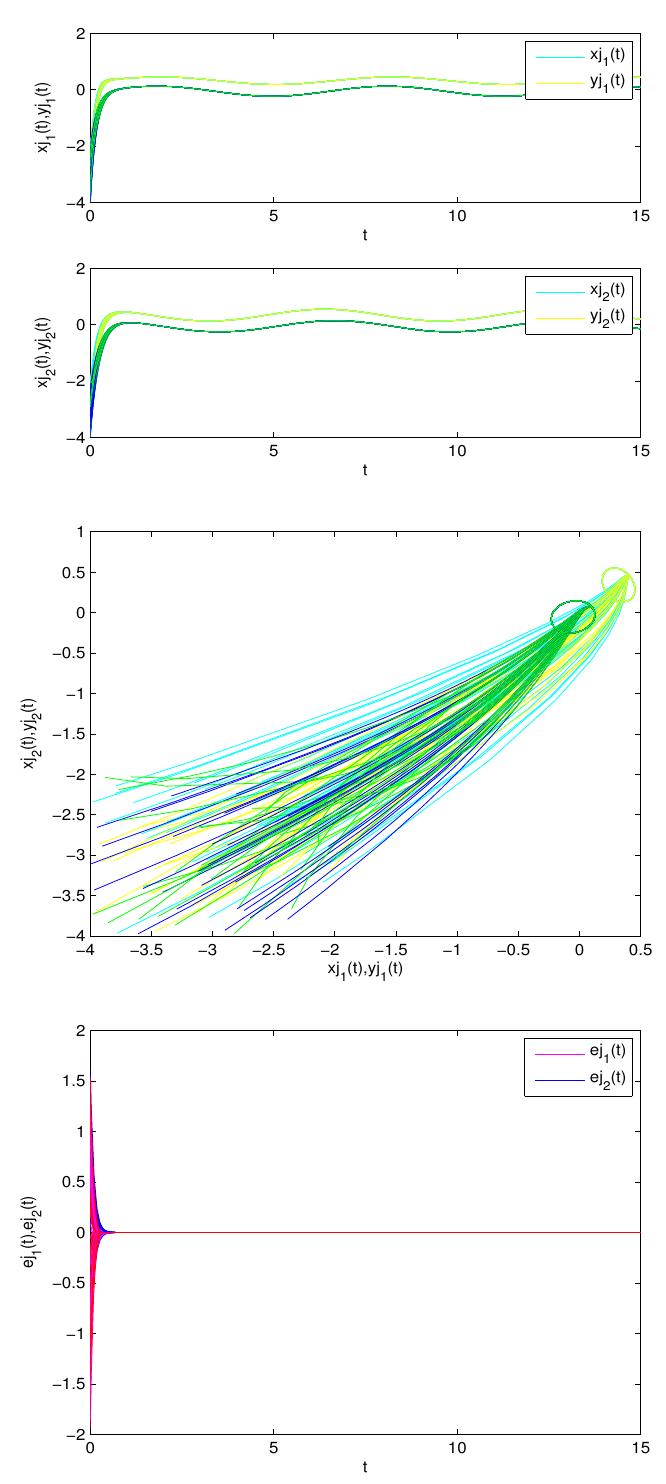
Figure 11. Instantaneous error states for the J part between for the variable ˘ x of (18) and ˘ y of (19) under 30 random initial values for two kinds of